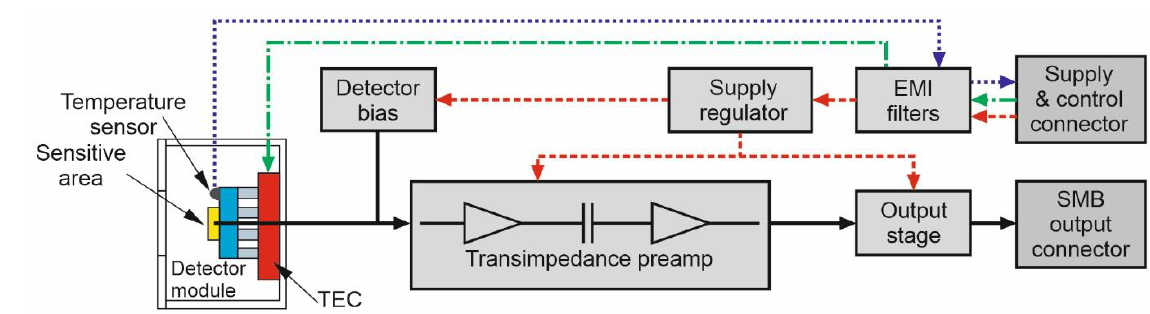
Figure 2. Block diagram of the detection module. TEC, thermoelectric cooler; EMI, electromagnetic noise filter; SubMiniature version B connector (SMB).